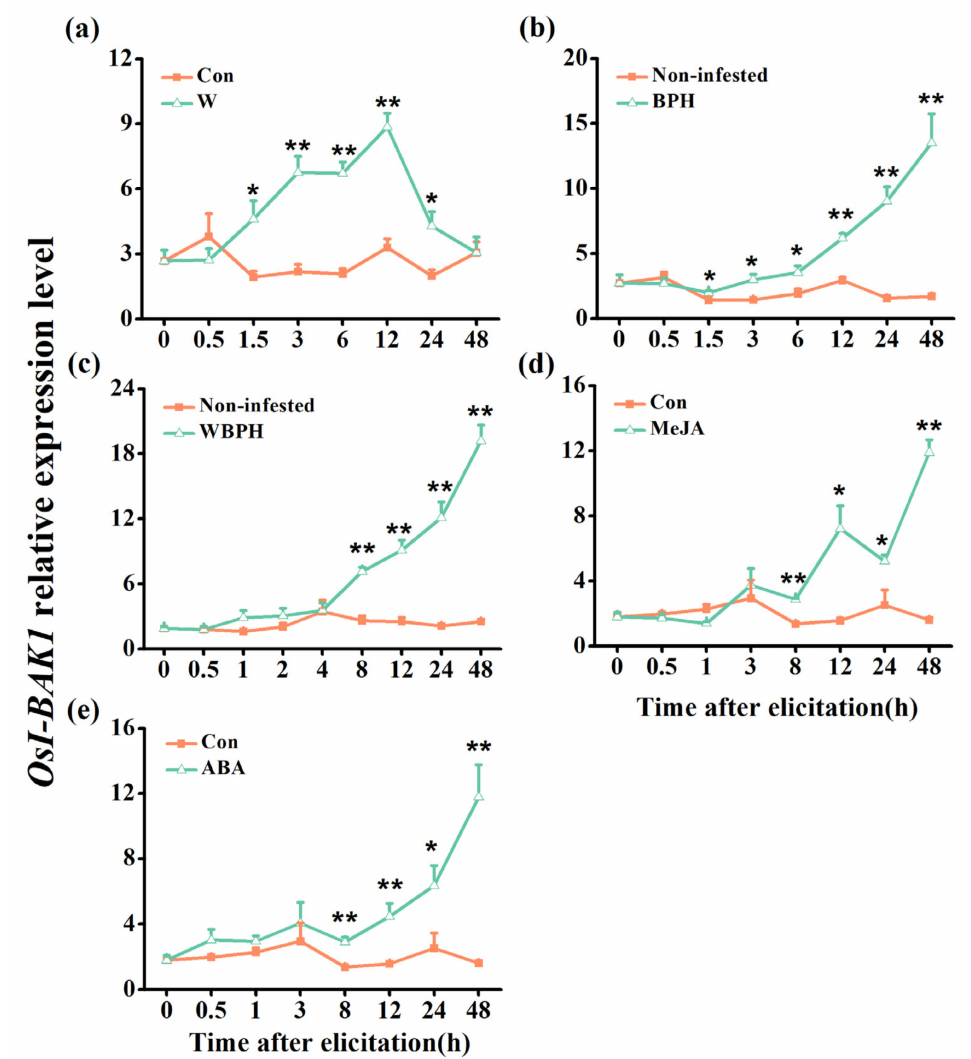
Figure 2. Relative expression levels of OsI-BAK1 in rice leaf sheaths after different treatments. Mean transcript levels (+SE, n = 5) of OsI-BAK1 in rice leaf sheaths that were mechanically wounded (W, ( a )), infested with gravid brown planthopper (BPH) females ( b ), gravid white-backed planthopper (WBPH) females ( c ) or treated with methyl jasmonate (MeJA) ( d ) or abscisic acid (ABA) ( e ). Non- infested, plants that were covered in an empty glass cylinder without BPH or WBPH; Con, control plants corresponding to mechanical wounding or MeJA or ABA treatment. Asterisks represent significant differences between the treatments and controls at each time point (* p < 0.05 and ** p < 0.01; Student’s t